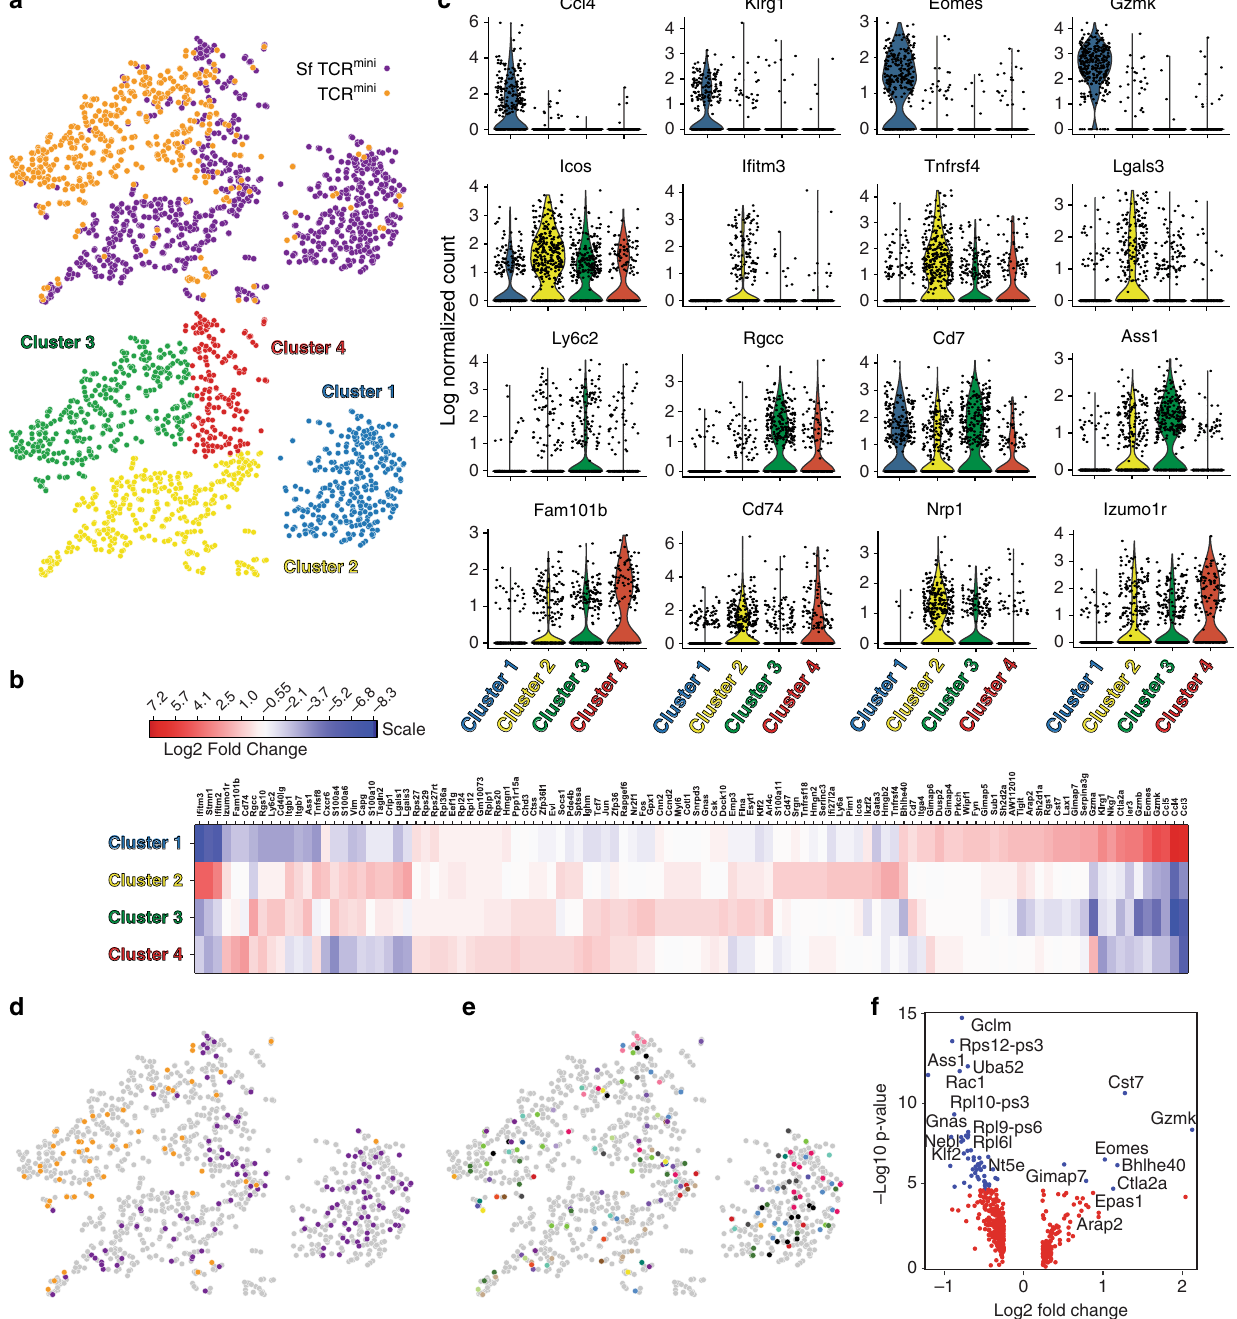
Fig. 7 Analysis of DE genes in individual SfCD4 + Foxp3 GFP − and CD4 + Foxp3 GFP − effectors. a 2D visualization of t-SNE plot separating peripheral CD4 + CD44 + CD62L − Foxp3 GFP − cells from Sf and healthy TCR mini mice. a Heatmap of differentially expressed (DE) genes in clustered CD4 + Foxp3 GFP − cells from SfTCR mini and TCR mini mice. Grid cells are colored by a gene ’ s log2 fold change . c Violin plots show the expression of a selected set of DE expressed genes among the different clusters. d 2D visualizations of t-SNE projections of individual CD4 + Foxp3 GFP − cells from TCR mini (orange) and SfCD4 + Foxp3 GFP − from SfTCR mini (purple) mice that shared 23 common TCRs. e 2D imaging of t-SNE dimensionality reduction plot with 23 different TCRs shared by CD4 + single cells in both studied strains. The same color (but not gray) in the plot represents the identical TCR clonotypes. Sequences of TCR α CDR3 regions, coding color and their frequencies in each strain are listed in Supplementary Data 11. f Volcano plot shows aggregate of DE genes of all shared clonotypes CD4 + Foxp3 GFP − cells from SfTCR mini and TCR mini control mice. Genes most relevant to these cells distinctive functional status are speci fi ed. Source data are provided in a Source Data fi le